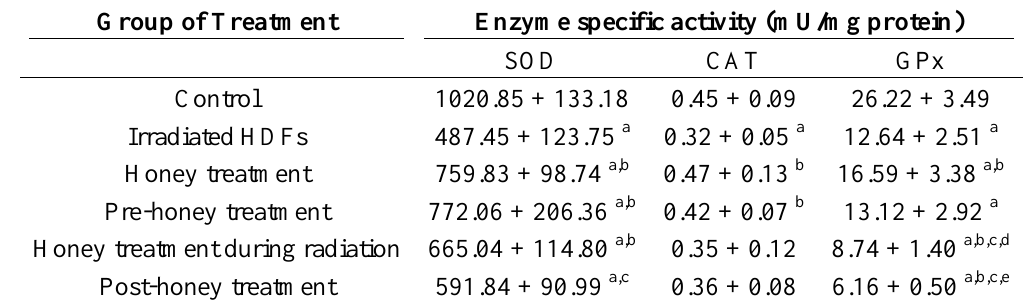
Table 1. The specific activities of superoxide dismutase (SOD), catalase (CAT) and glutathione peroxidase (GPx) in different HDFs treatment